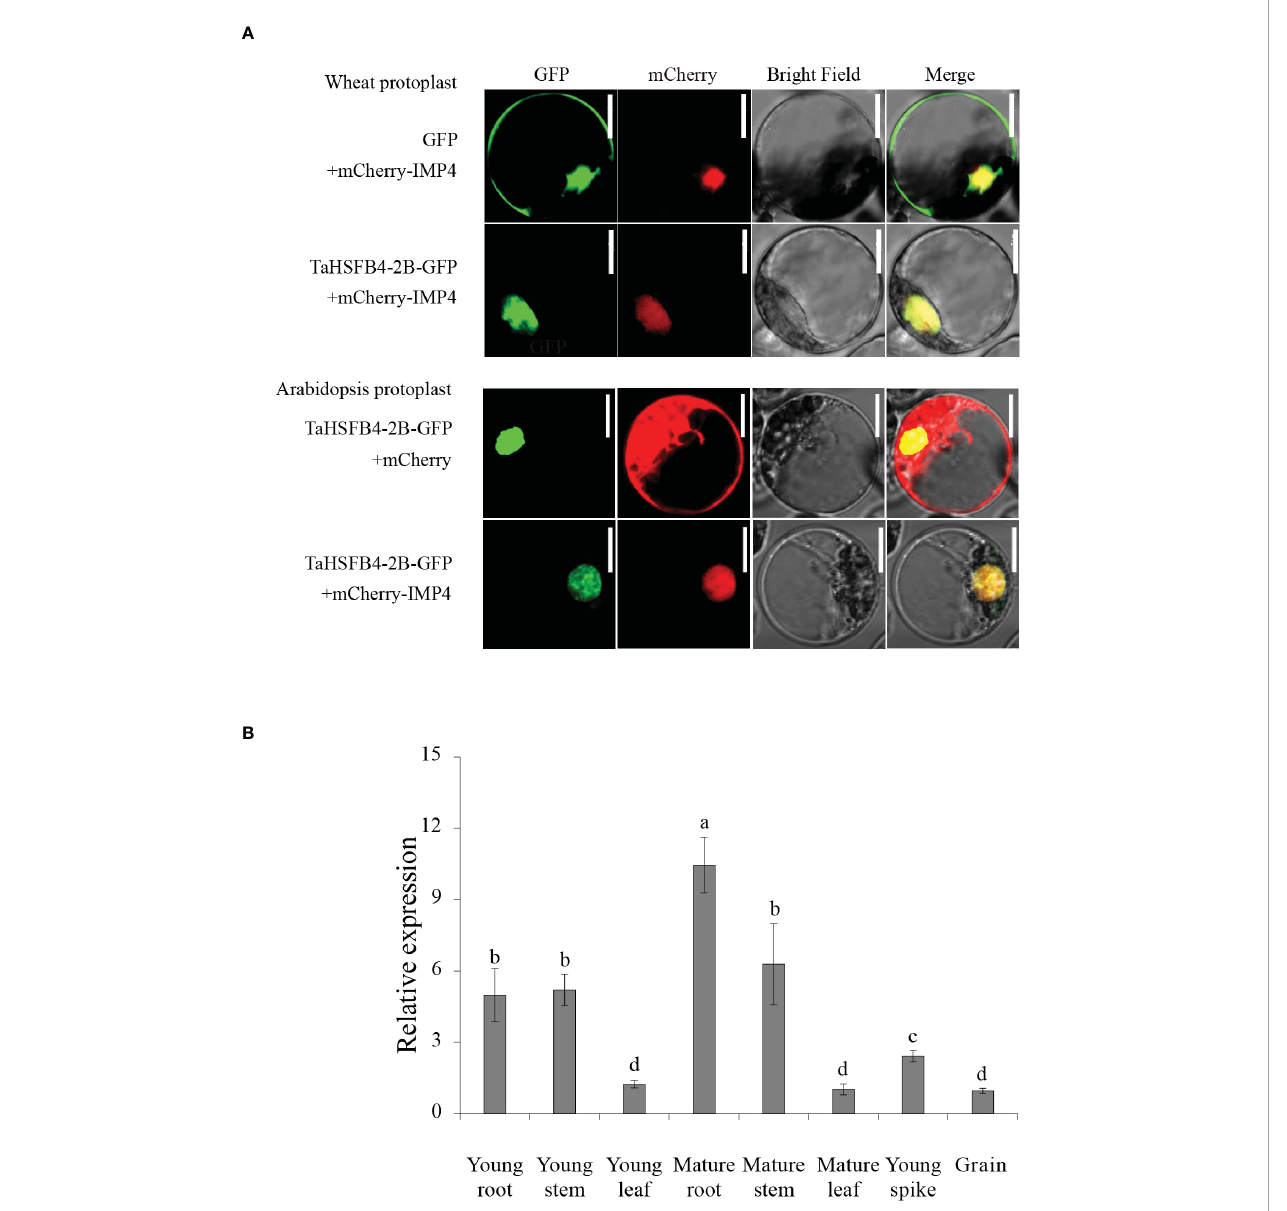
FIGURE 5 TaHSFB4-2B subcellular localization in Triticum aestivum and Arabidopsis thaliana protoplast and TaHSFB4-2B tissue speci fi c expression pro fi les. (A) TaHSFB4-2B Subcellular localization in Triticum aestivum and Arabidopsis thaliana protoplast. mCherry-IMP4 was used as nuclear marker. Row 1: Free GFP and mCherry-IMP4 were transiently expressed in Triticum aestivum protoplast; Row 2: TaHSFB4-2B-GFP and mCherry-IMP4 were transiently expressed in Triticum aestivum protoplast; Row 3: TaHSFB4-2B-GFP and free mCherry were transiently expressed in Arabidopsis thaliana protoplast; Row 4: TaHSFB4-2B-GFP and mCherry-IMP4 were transiently expressed in Arabidopsis thaliana protoplast. Green channel: GFP fl uorescence signals; Red channel: mCherry fl uorescence signals; Scale bar: 10 m m. (B) TaHSFB4-2B tissue speci fi c expression pro fi les in wheat. The young root, mature root, young stem, mature stem, young leaf, mature leaf, young spike and grain of wheat at different growth stages were sampled the transcription levels of TaHSFB4-2B were measured by RT-qPCR. The transcription level of TaHSFB4-2B was normalized with TaACTIN . Values are Mean ± SD, n=3. a, b, c and d indicate the statistical differences between different tissues determined by LSD ( P < 0.05) of variance (ANOVA) method. Same letters: no signi fi cant difference, and different letters: signi fi cant difference between the two